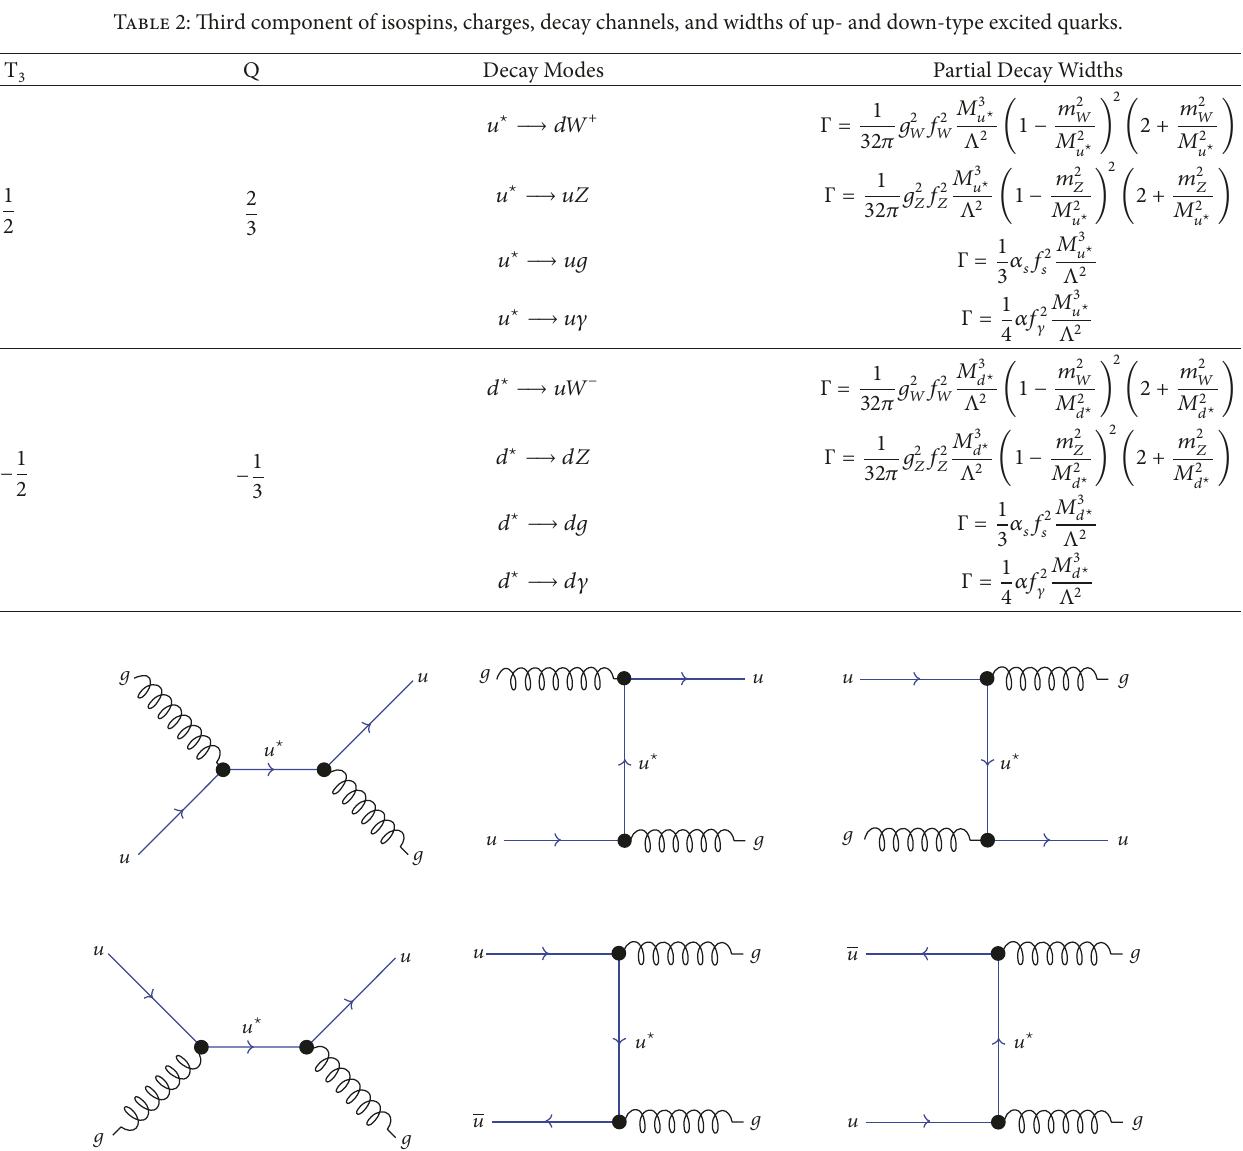
Figure 2: Feynman diagrams for direct (first column) and indirect production of 𝑢 ⋆ at 𝑝𝑝 colliders.